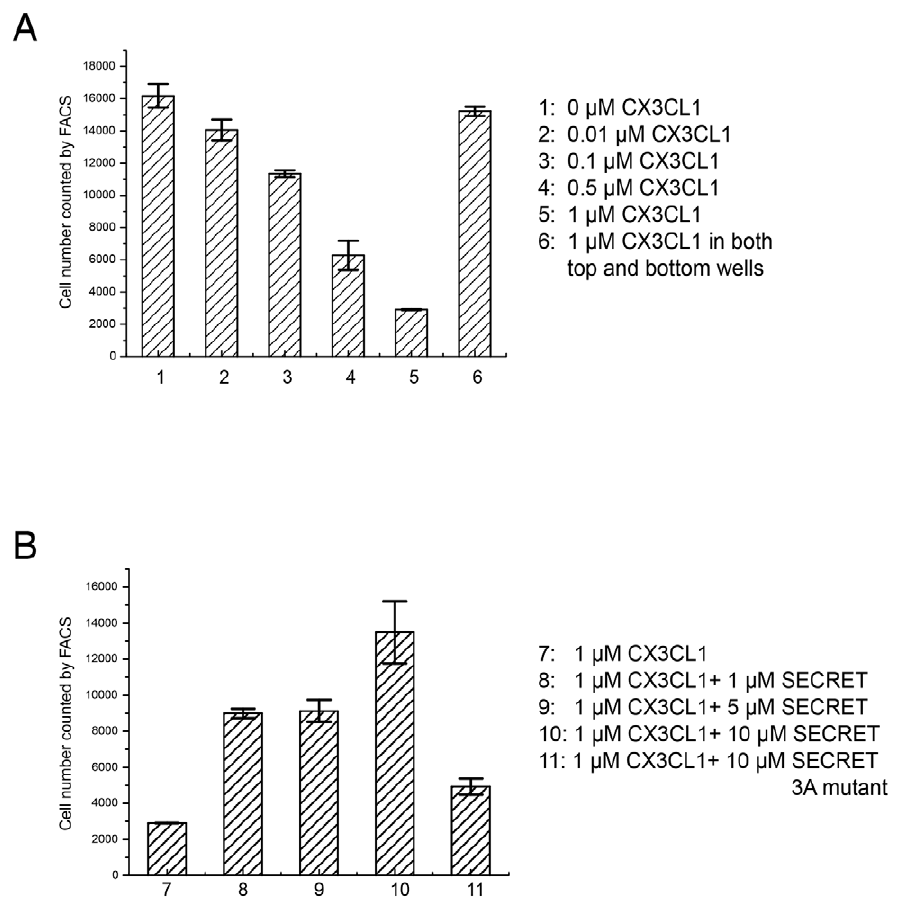
Figure 6. CX3CL1-induced migration of RAW 264.7 cells. (A) The number of cells remaining in the top well counted by FACS after a 4-h chemotaxis assay are indicated with CX3CL1 in concentrations of 0.01, 0.1, 0.5, and 1.0 m M in the bottom well, as well as the same concentration 1.0 m M in both top and bottom wells. (B) The number of cells remaining in the top well counted by FACS after a 4-h chemotaxis assay are indicated with CX3CL1, CX3CL1 pre-incubated with the SECRET domain in different molar ratio (1:1, 1:5, and 1:10), and CX3CL1 pre-incubated with the SECRET domain triple mutant D167A/E169A/D316A in a 1:10 molar ratio. The D167A/E169A/D316A mutant is referred as 3A mutant in the figure.